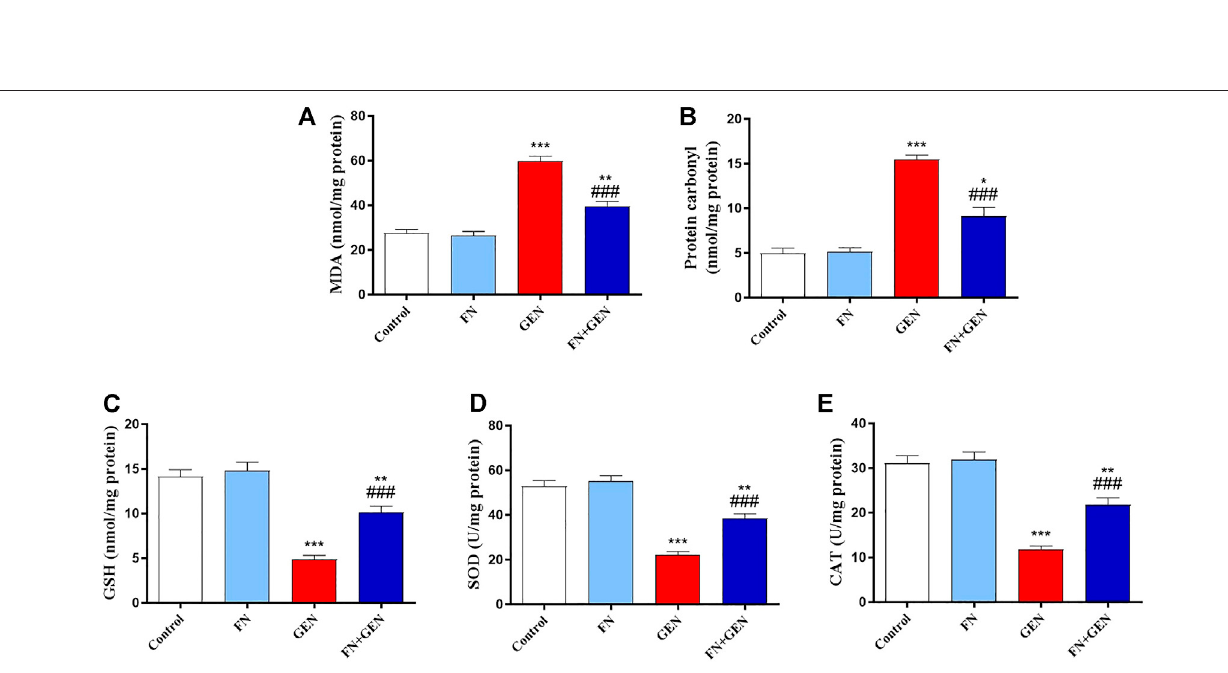
Frontiers in Pharmacology |